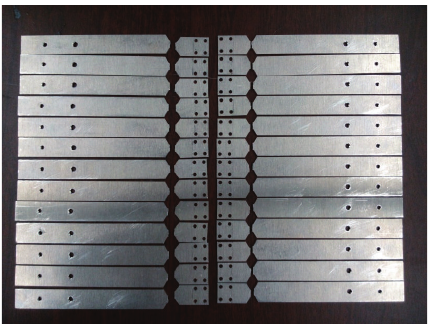
Figure 13: 𝑆 - 𝑁 curve for Al 6061-T6.